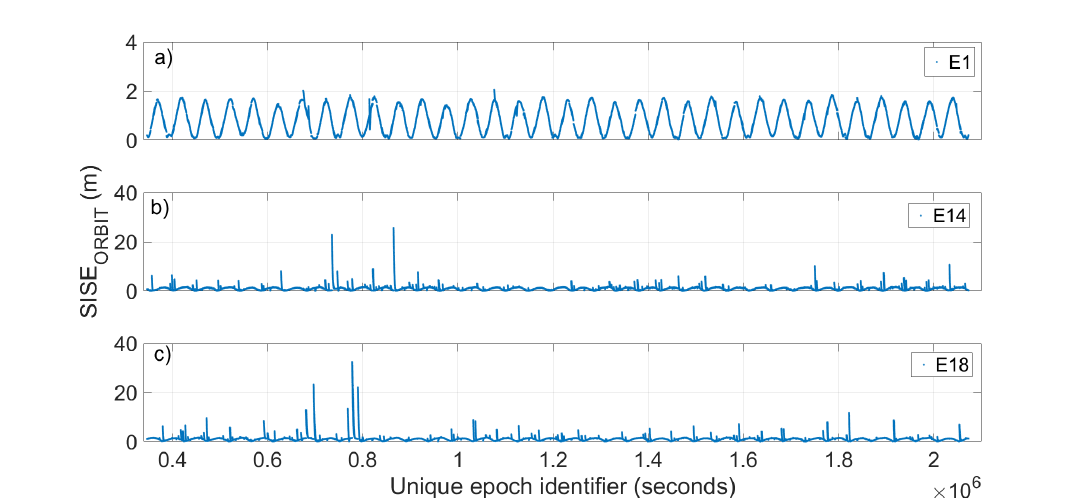
Figure 8. SISE orbit versus time obtained with an ephemeris validity time of 14,400 s (4 h). Satellite 1 (E1), Milena (E14) and Doresa (E18) are plotted in ( a – c ), respectively. To have a better representation, in ( b , c ), the maximum value of the SISE orbit shown is 3 m.